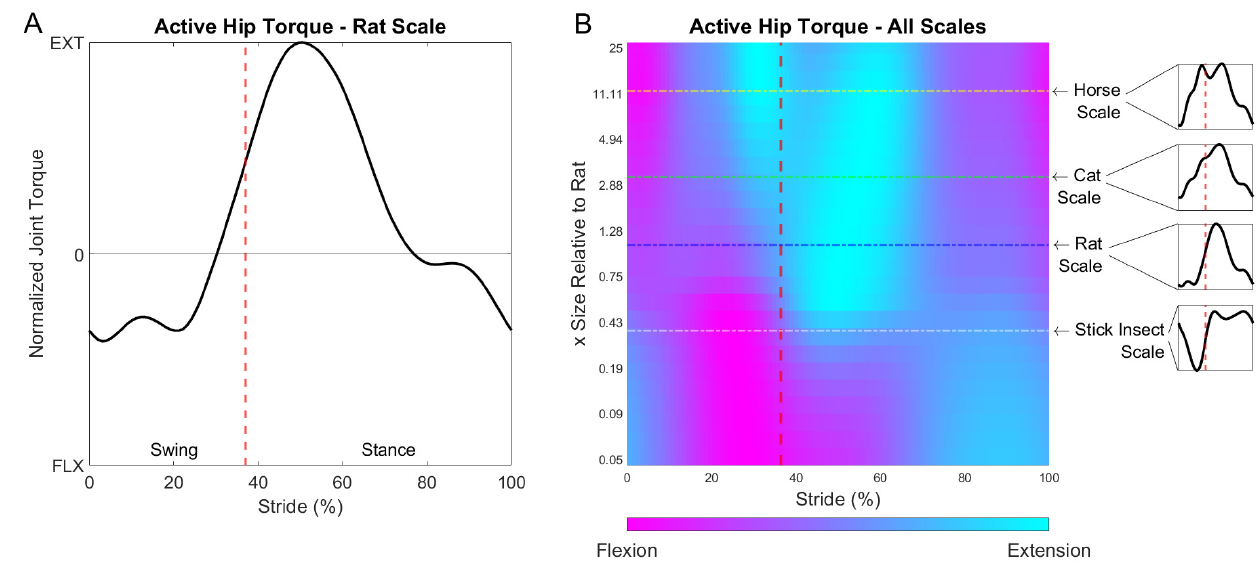
Figure 4. ( A ) Modeled active muscle torque in the hip joint for the model at rat-scale. ( B ) Modeled active muscle torque across a range of size-scales. The flexion-extension profile changes due to size-scale, as indicated by the magenta (flexion) and cyan (extension) coloring. Specific animal sizes are called out to contextualize the general scale of the rat model at which the active hip torques are calculated. The swing-stance transition is represented by the vertical dashed line.